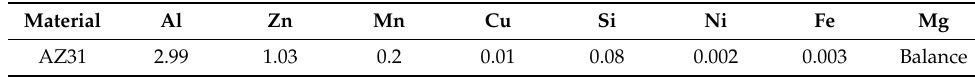
Table 1. Chemical composition of AZ31 magnesium alloy sheet.